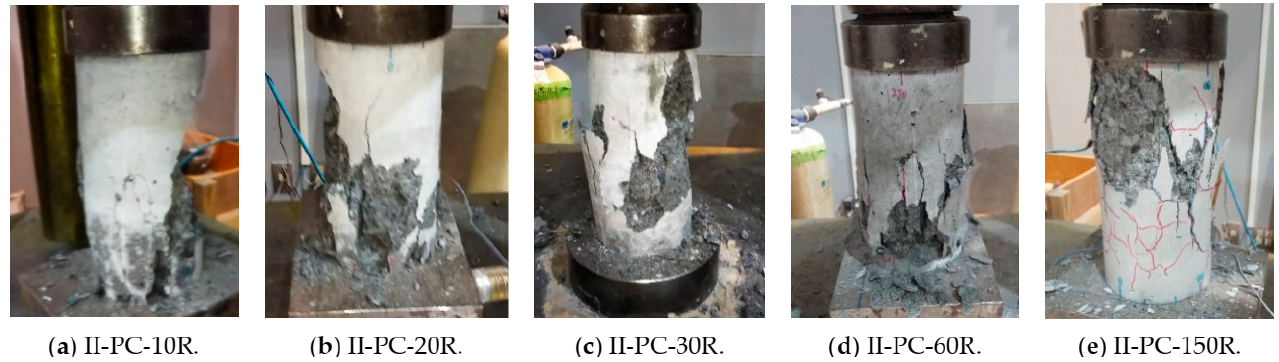
Figure 11. Failure modes of series II specimens under uniaxial